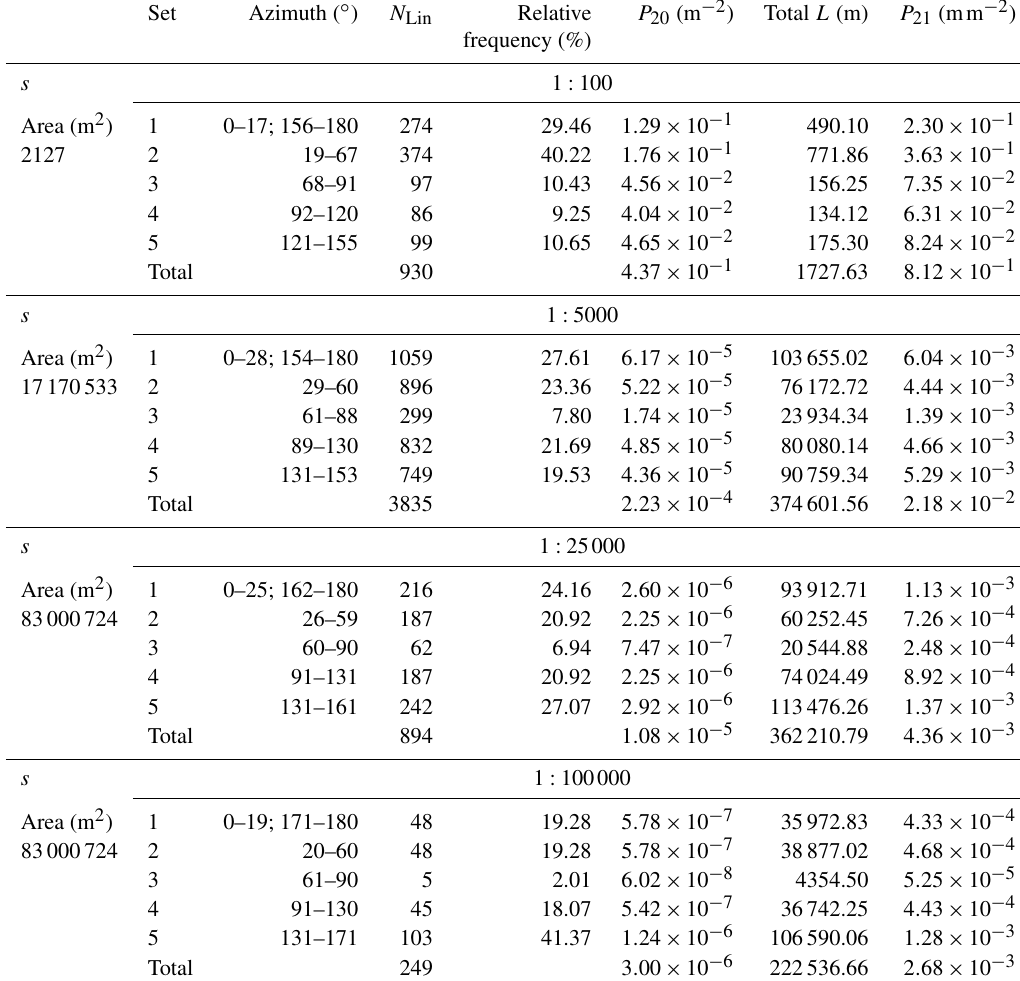
Table 2. Table presenting the orientation data for the identified lineament sets for each scale of observation. Azimuth ( ◦ ) represents the average strike of the manually picked lineaments. Total L represents the sum of the length of all picked lineaments in each map for each set.